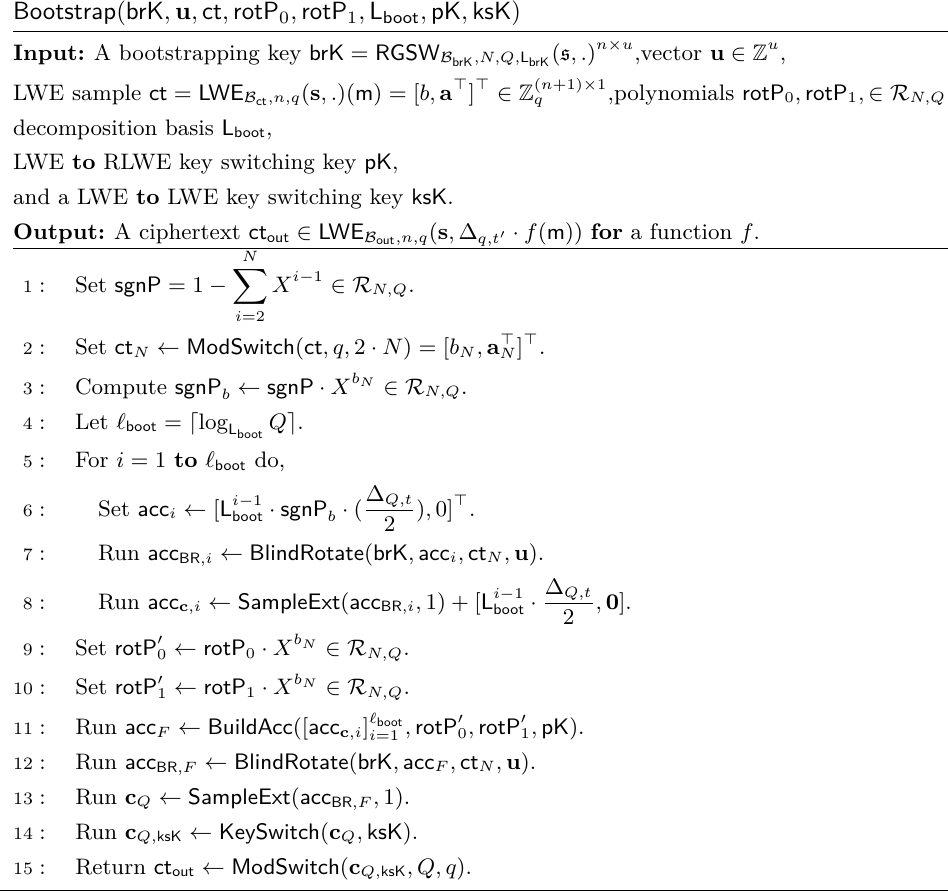
Figure 4: Full domain bootstrapping